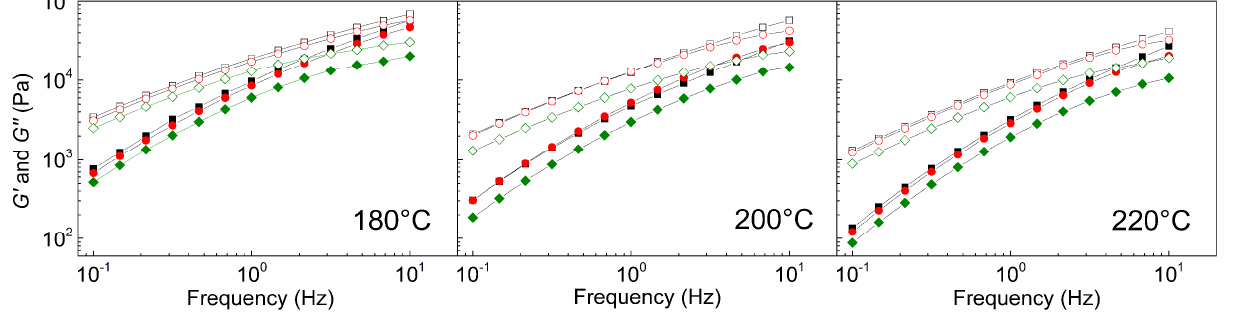
Figure 7. Dependence of the storage (solid symbols) and loss (open symbols) moduli against fre- quency, for neat PVDF (black squares), PVDF/GO (red spheres) and PVDF/GO-PBA (green dia- monds) at various temperatures.